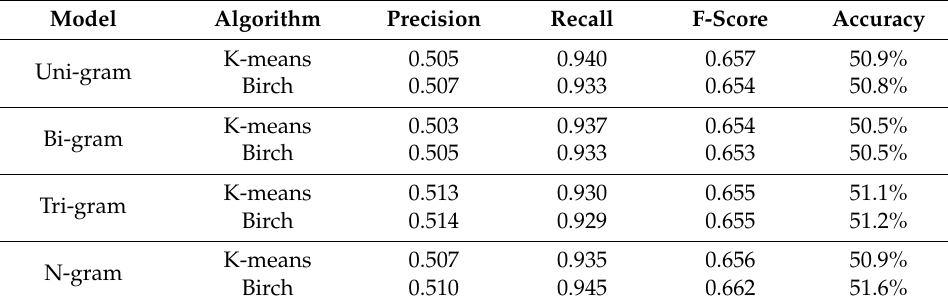
Table 3. Summary for clustering algorithms with n-gram model on test dataset.